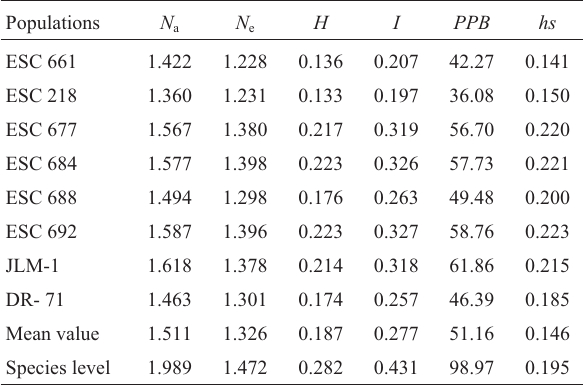
Table 3 - Genetic diversity index within populations of Calydorea crocoides